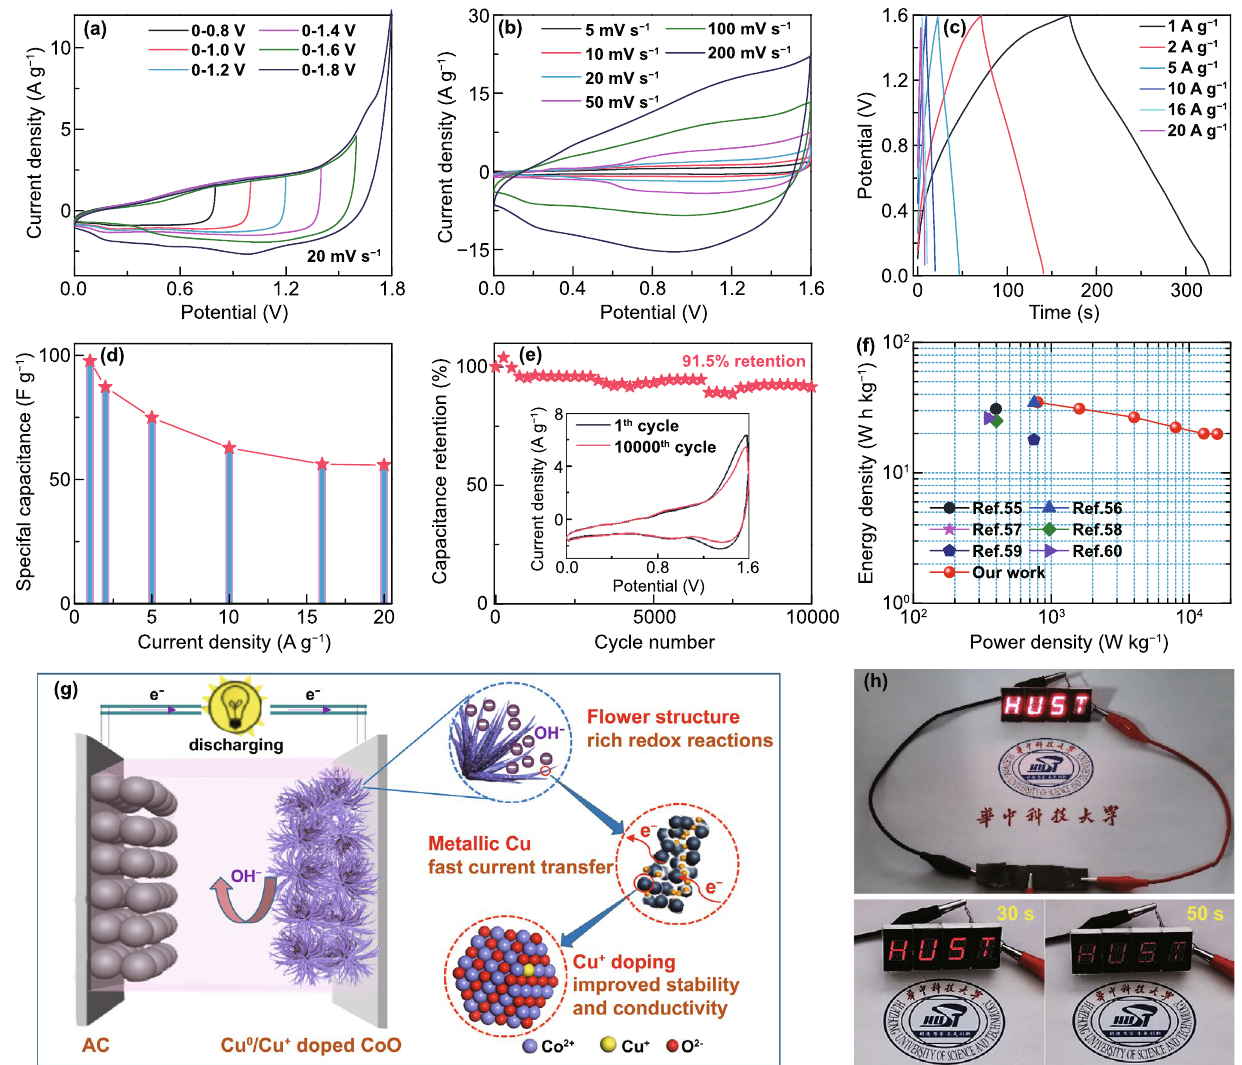
Fig. 5 Electrochemical performance of Cu 0 /Cu + co-doped CoO//AC AHSC device: a CV curves at different potential windows. b CV curves at different scan rates. c GCD curves. d Specific capacitance. e Cycling performance (inset: CV curves of the first and the last cycle). f Ragone plot. g Schematic of Cu 0 /Cu + co-doped CoO electrode. h Symbols of “HUST” lighted by our